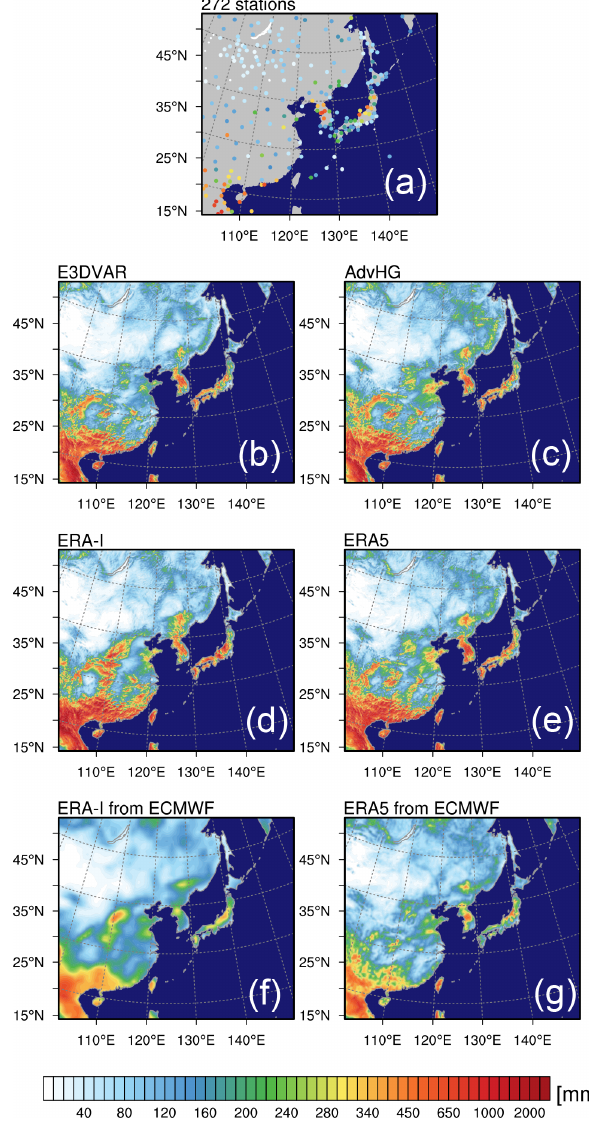
Figure 14. Same observations as in Fig. 13, but for July